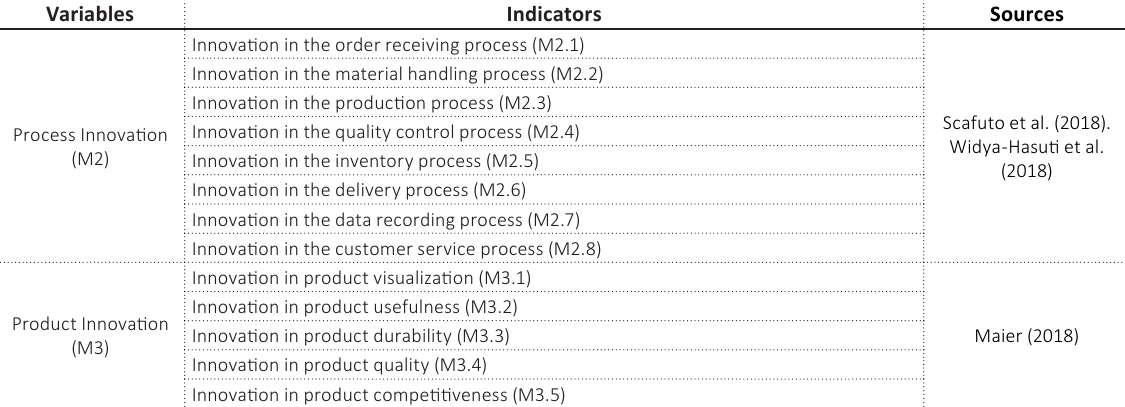
Table 1 (cont.). Research variables and